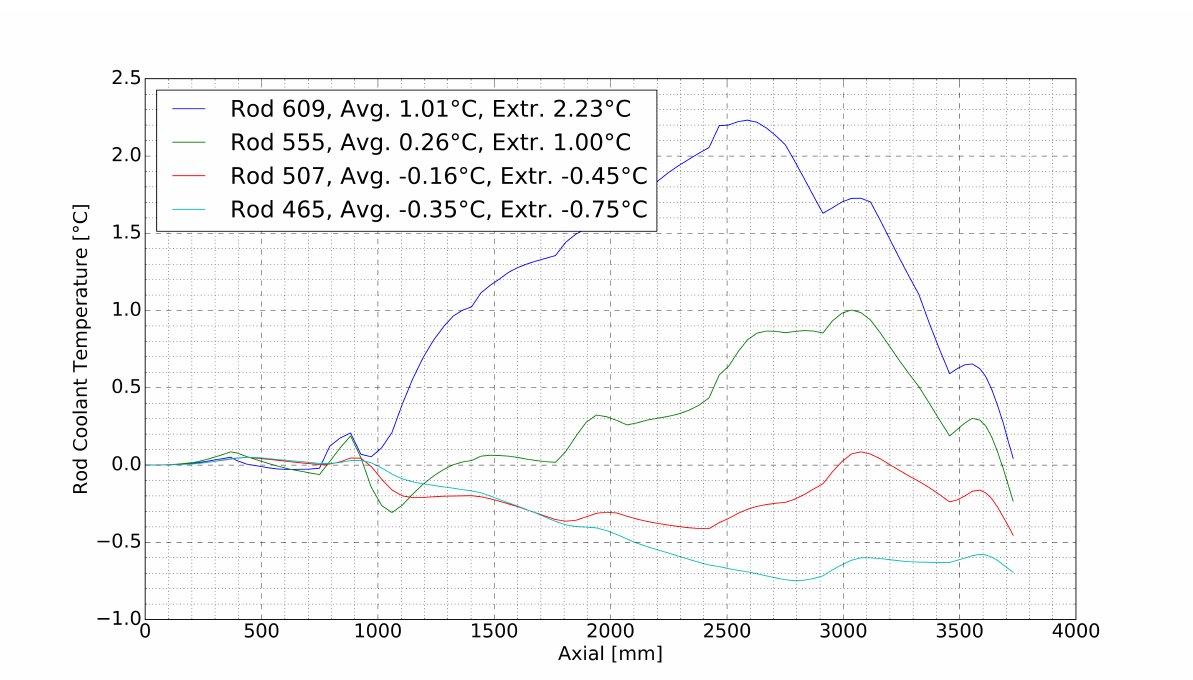
Figure 9. Example of rod coolant temperature differences -